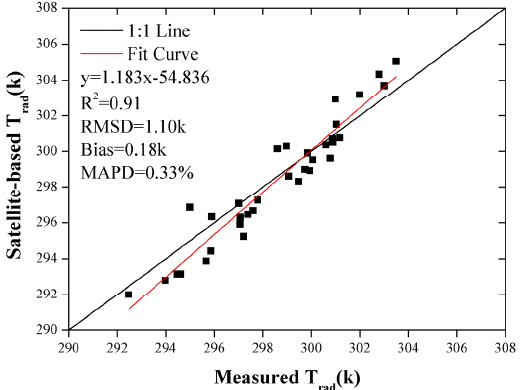
Figure 3. Scatterplot of the ASTER-derived surface radiometric temperatures versus surface temperatures measured by infrared thermometers at the study field.